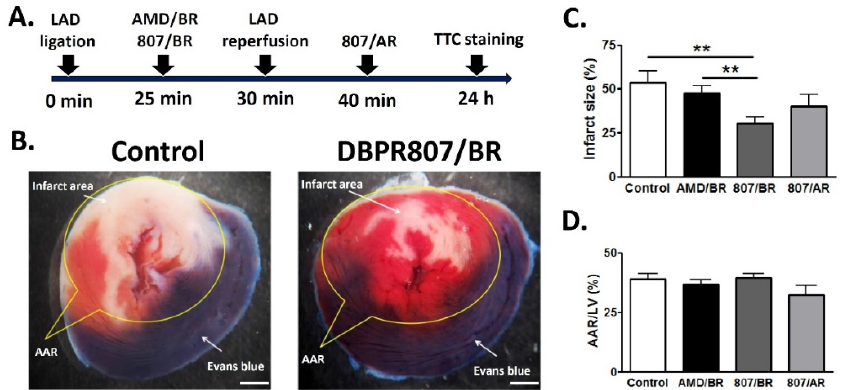
Figure 3. Infarct size assessment in rats. Rats were treated with vehicle AMD3100/BR (5 mg/kg, SC) or DBPR807/BR (5 mg/kg, SC) at 25 min after LAD artery ligation or DBPR807/AR (5 mg/kg, SC) at 40 min after LAD artery ligation (control, n = 10; AMD3100/BR or DBPR807/BR, n = 15; DBPR807/AR, n = 8). AAR and infarct size were evaluated 1 day after IR injury in heart via Evans blue and TTC-staining; AMD3100 (infarct area/AAR = 43%); DBPR807 (infarct area/AAR = 30%). ( A ) Treatment protocol. ( B ) Viable tissue is red, and the infarct area is white; scale bar = 1 mm. ( C ) Infarct size was determined by the infarct area/AAR ratio and quantified as a percentage. ( D ) AAR/LV area ratio was quantified as a percentage. The data are presented as mean ± SEM. Statistical analysis was performed by t -test: ** p <